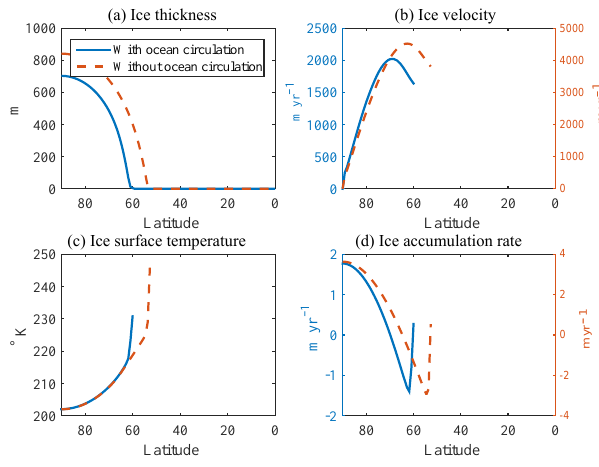
Figure 2. (a) Ice thickness h and (b) meridional velocity v profiles in partial ice cover scenario with effective emissivity ε = 0 . 7, with and without ocean circulation. Oceanic transport is seen to dramat- ically affect the ice predictions. (c) Ice surface temperature T s and (d) ice basal accumulation rate in partial ice cover scenario with ef- fective emissivity ε = 0 . 7, with and without ocean circulation. The accumulation term stabilizes the ice margin, and the model pro- duces reasonable values of ice surface temperatures. M is positive over the region of ice cover, indicating net accumulation of ice, and negative values of M beyond the ice margin indicate any ice present would be